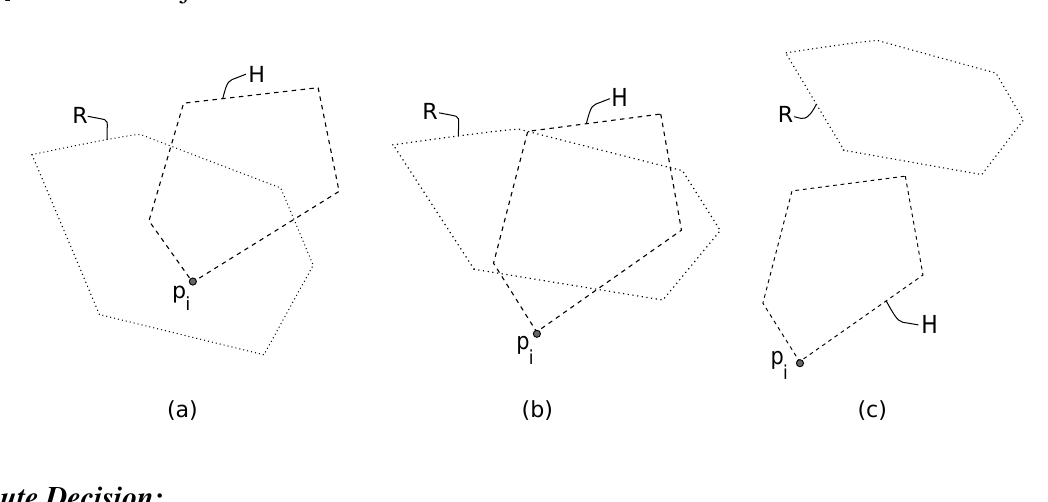
Figure 2. Routing decisions: (a) node i executes query if p